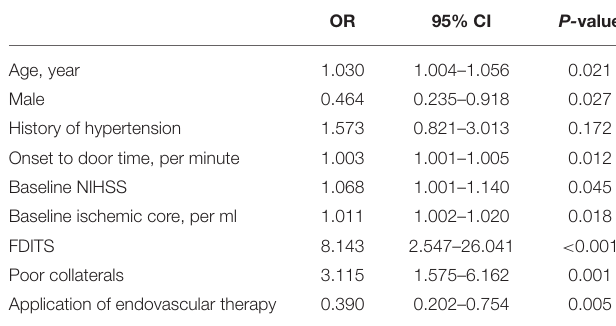
TABLE 2 | Binary logistic regression analysis for unfavorable